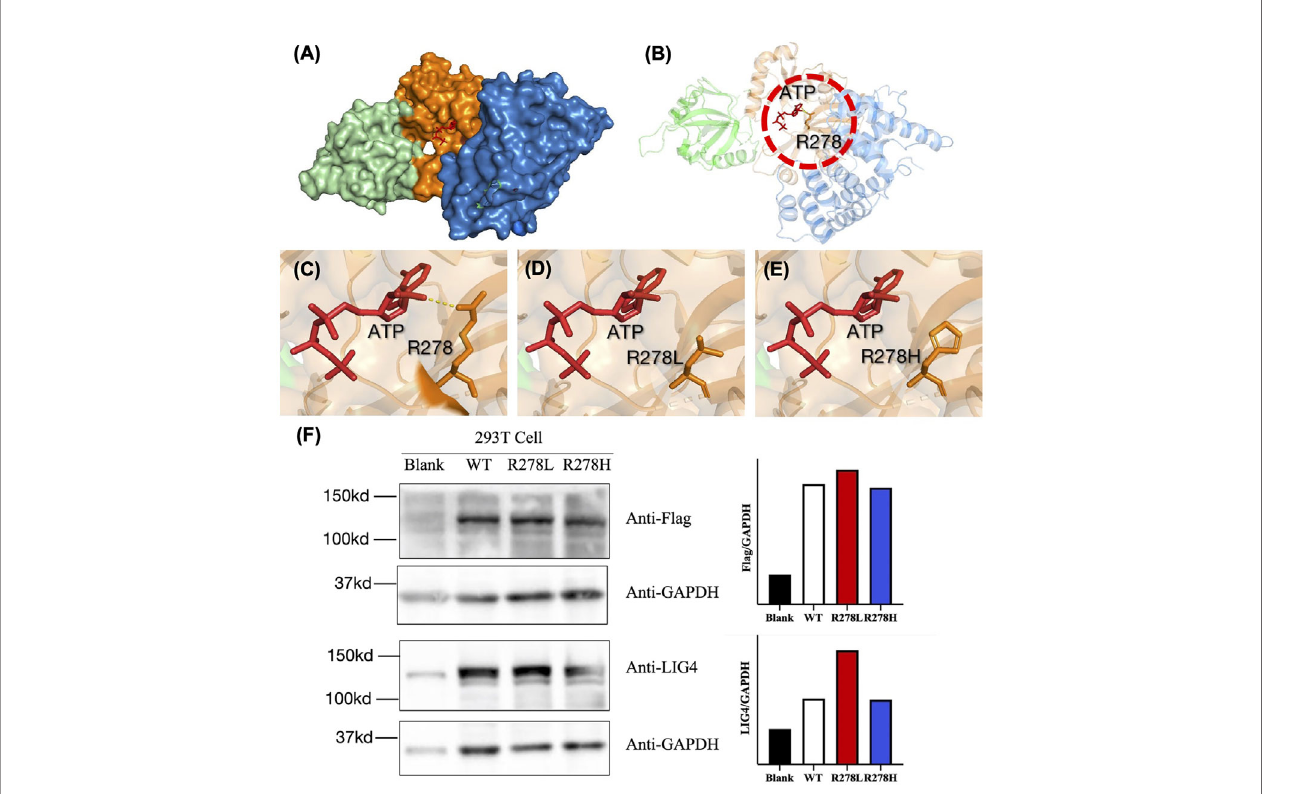
FIGURE 3 | (A) Structural characterization of the catalytic domain of human DNA LigIV (PDB ID code 3W5O). The domains are shown in blue (DBD), orange (NTD), and cyan (OBD). The structure surrounding by Arg-278 (indicated by the dashed circle in (B) is enlarged. (C – E) The interaction between ATP and amino acids R278, R278L, and R278H was drawn using a tool packaged in PymoL. (F) Western blot analysis of the LIG4 protein expression in the HEK293T cells transfected with WT or mutant LIG4 plasmid (p.R278L or p.R278H).